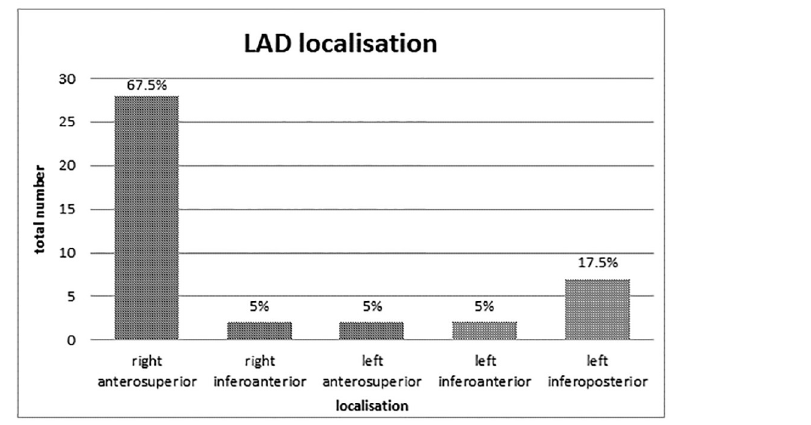
Fig 2. Overview of the total amount of left atrial diverticula and their localisation.